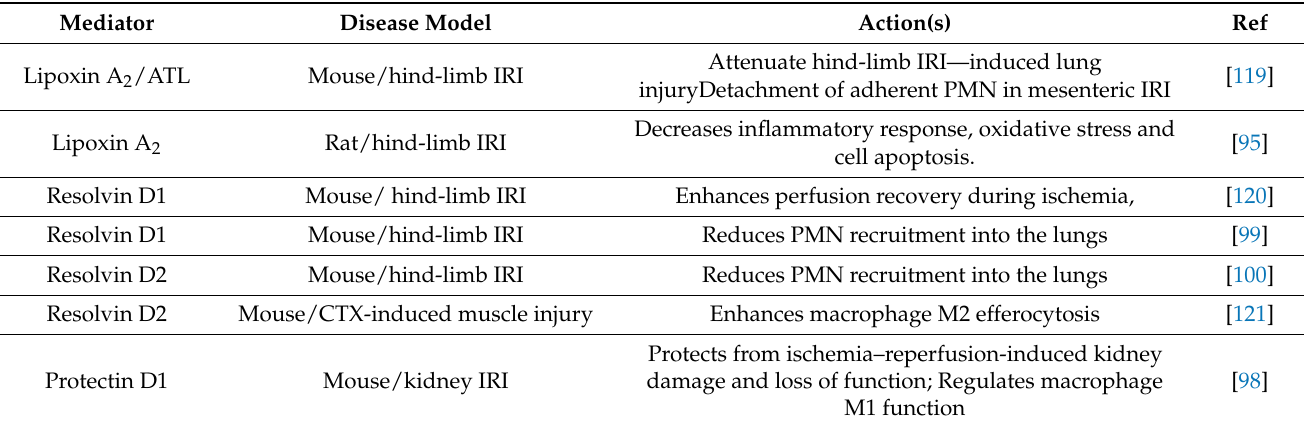
Table 1. Role of specialized pro-resolving mediators in skeletal muscle IRI disease models.